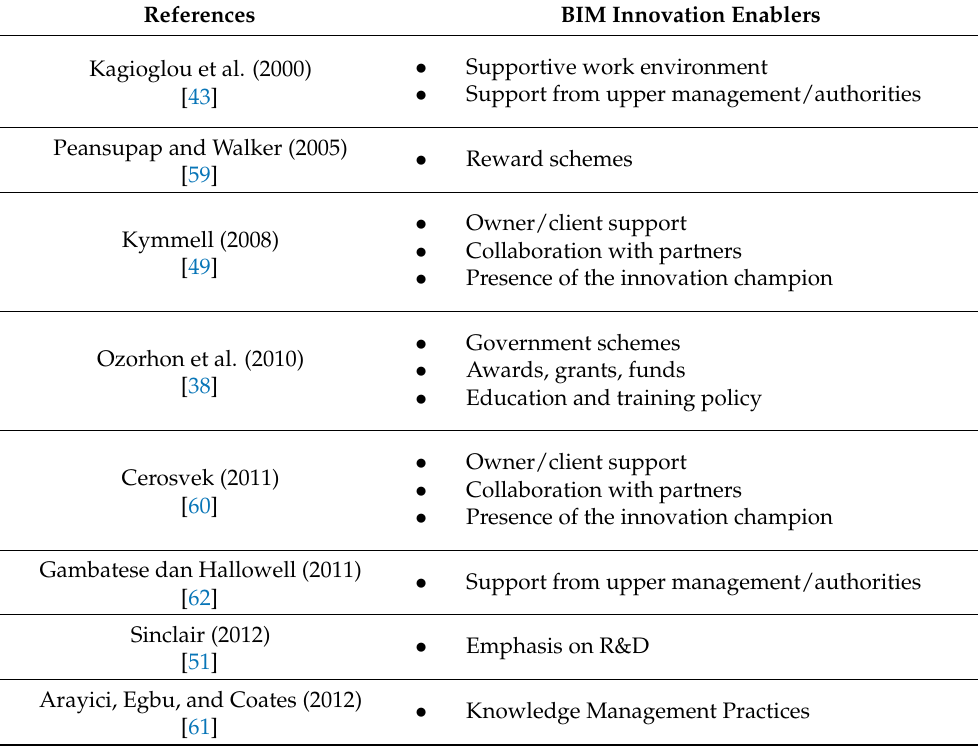
Table 4. The enablers of BIM